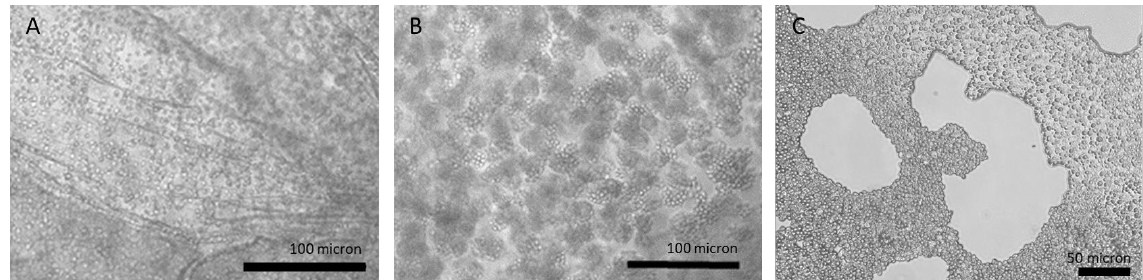
FIGURE 3: Yeast microcolonies form in alginate-encapsulated beads packed in immobilized cell reactors. Immediately after gelation (A), the interior of bead consists of primarily single, unbudded cells evenly dispersed throughout alginate matrix, but by 3 days in ICR (B), cells have evenly dispersed in clonal clusters of 4 or more cells. After 14 days in ICR (C), cells are tightly packed, occupying majority of matrix material. Hollow chambers are dispersed throughout beads, presumably formed by CO 2